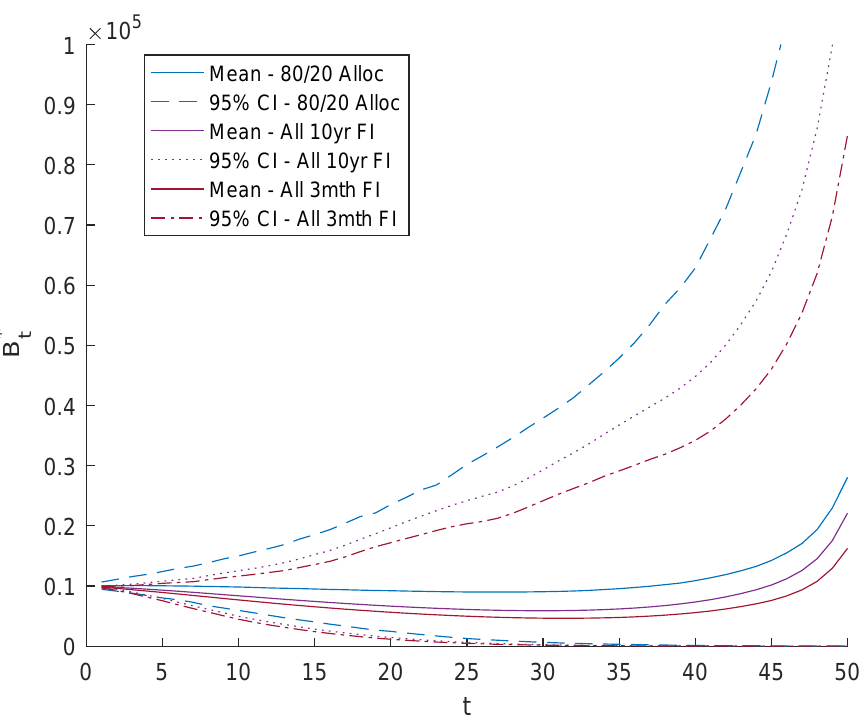
Figure 5. Annuity Payment Comparison—Without Volatility Management.